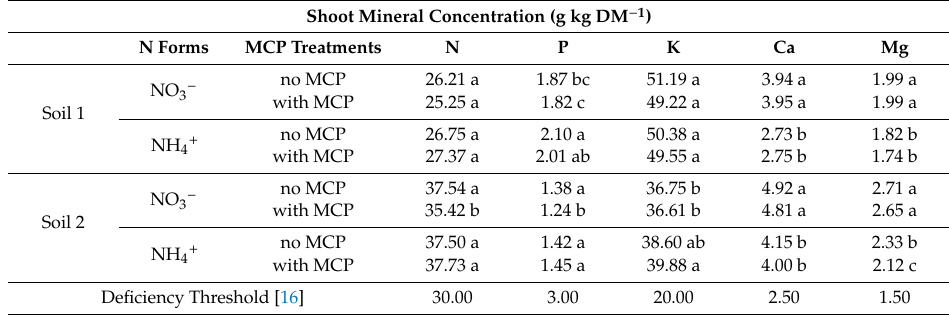
Table 3. Shoot concentrations of mineral nutrients of maize plants (cv. Jessy) on two low P soils. as a ff ected by MCP inoculation. Soil 1 (sandy-loam, pH 6.1, P CAL 7 mg kg − 1 soil) and Soil 2 (clay-loam, pH 5.9, P CAL 20 mg kg − 1 soil) receiving N fertilization in in form of Ca-nitrate (NO 3 − ) or DMPP-stabilized